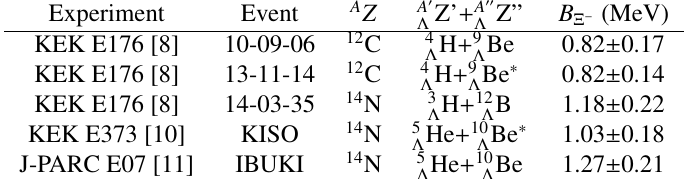
Table 1. Two-body Ξ − capture emulsion events from KEK and J-PARC